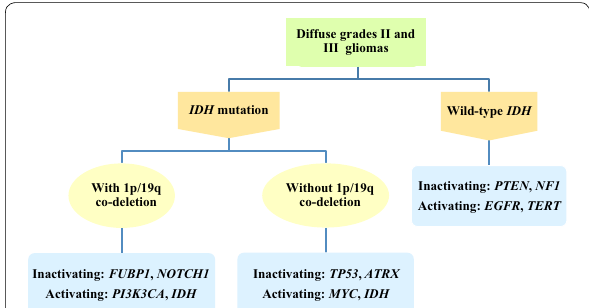
Fig. 1 Schematic representation of diffuse glioma molecular clas‑ sification. Lower‑grade gliomas, the diffuse low‑grade and interme‑ diate‑grade gliomas (World Health Organization grades II and III), are divided into three cohesive molecular subtypes based on molecular markers, including isocitrate dehydrogenase ( IDH ) mutations, co‑ deletion of chromosome arms 1p and 19q (1p/19q co‑deletion), and tumor protein p53 ( TP53